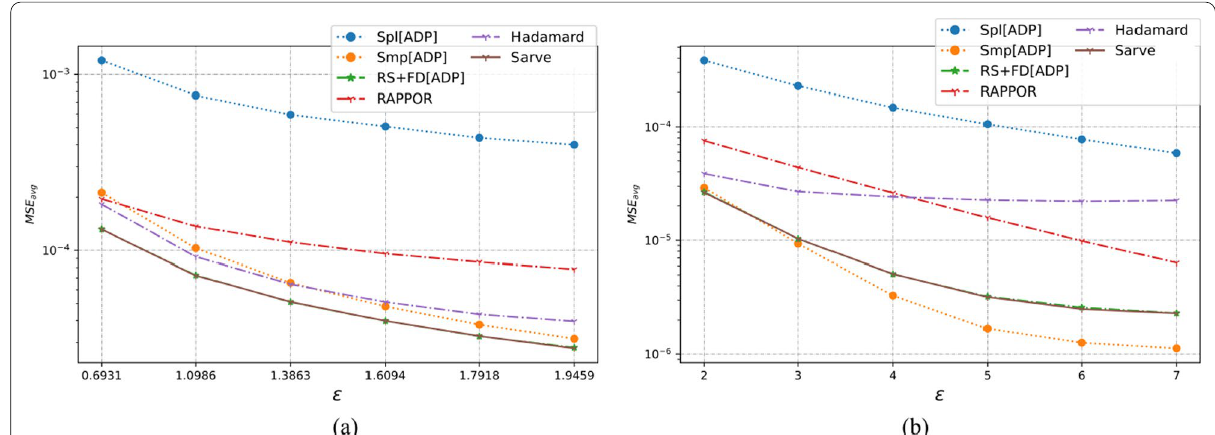
500,000, D 20 privatized using different randomization = =